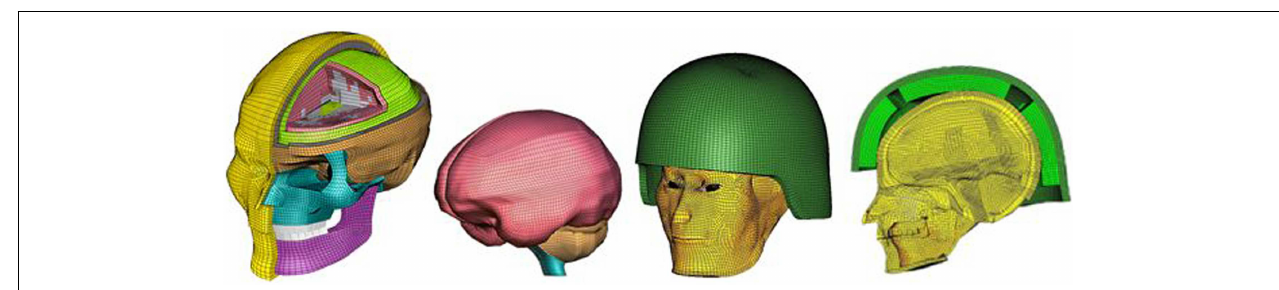
FIGURE 3 |An anatomically accurate finite element model of the human head (WSUHIM) and the integratedWSUHIM andACH helmet model .